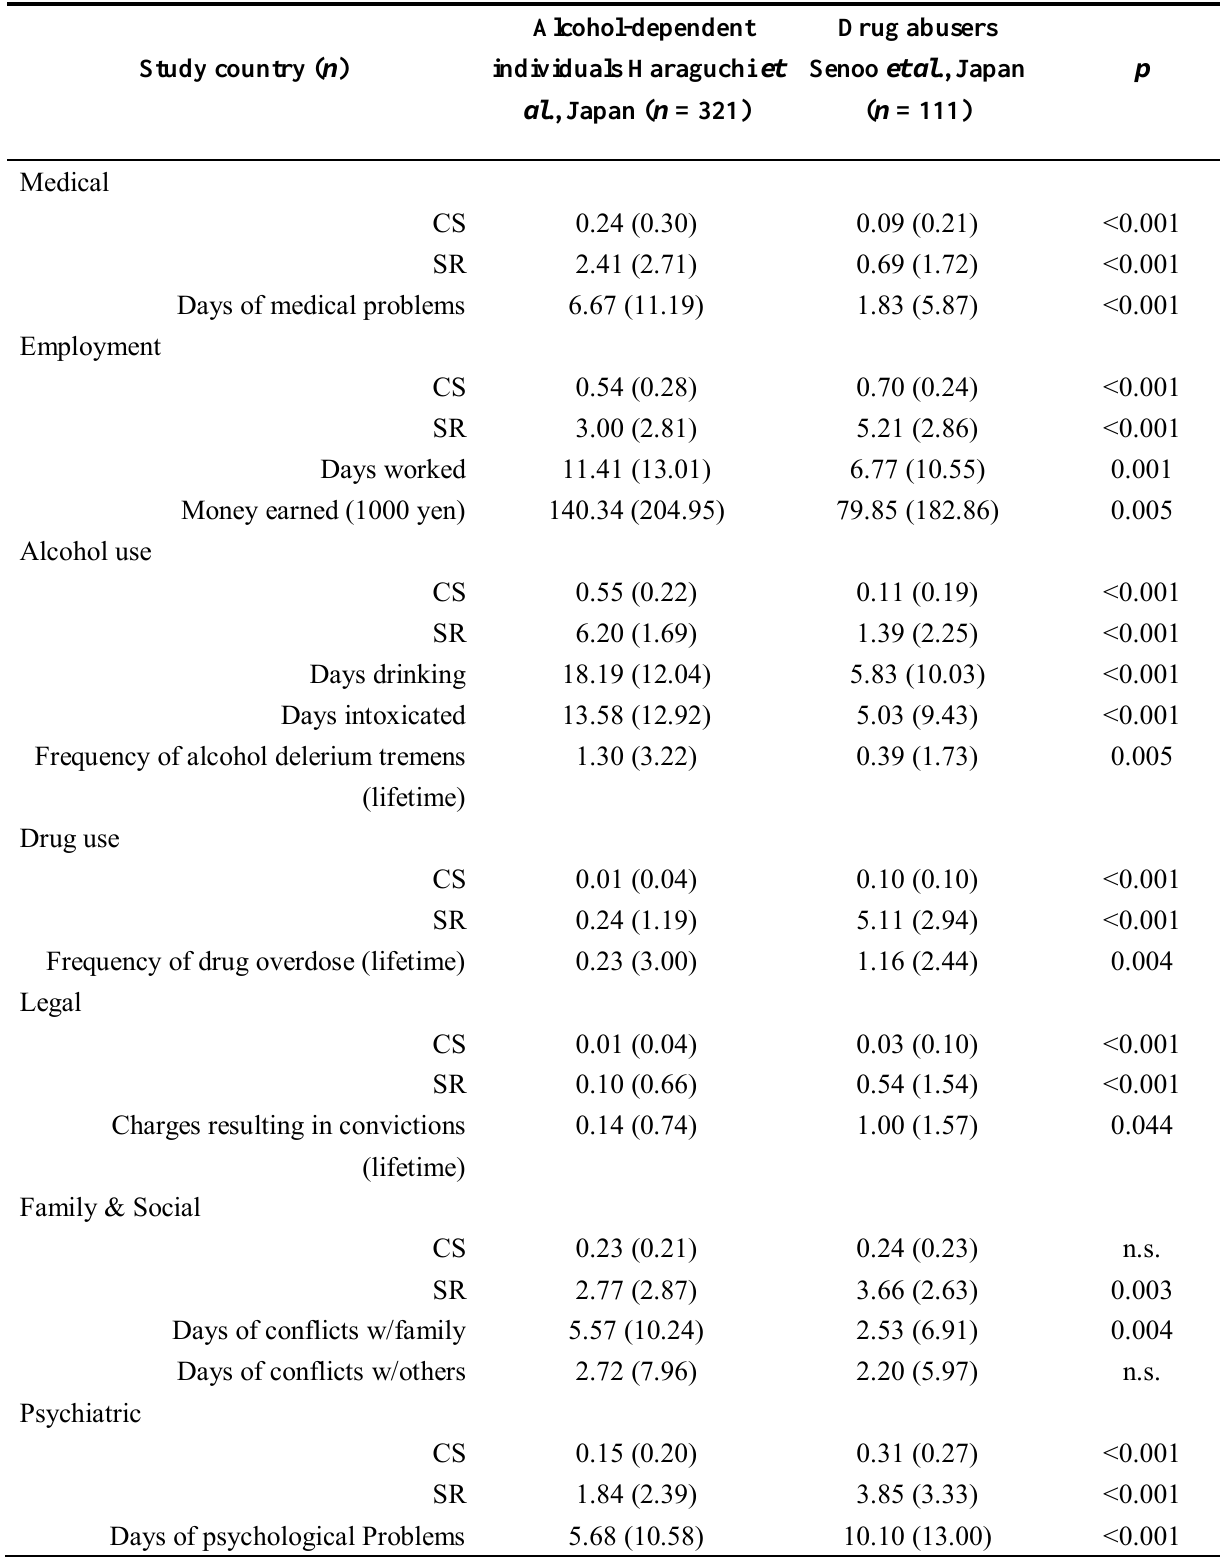
Table 4. Comparison between alcohol-dependent individuals and drug abusers in CS, SR, and other related